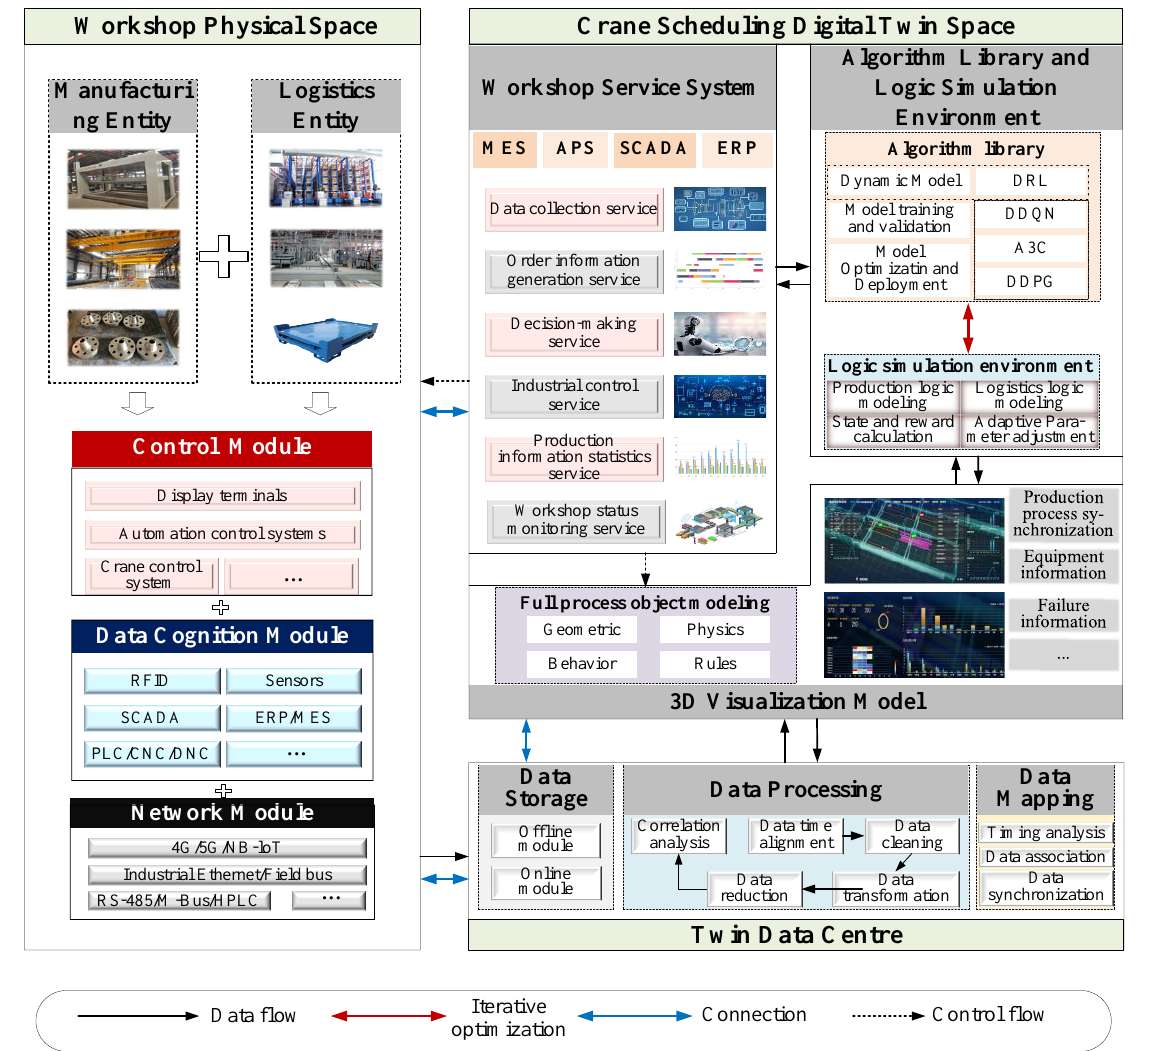
Figure 1. Crane transportation dynamic scheduling DT integrated application framework.